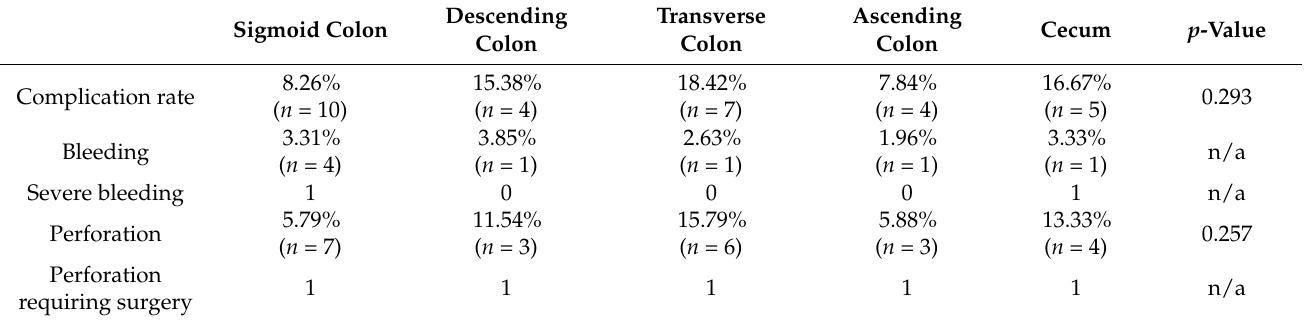
Table 6. Complications depending on the exact location of the lesions in the